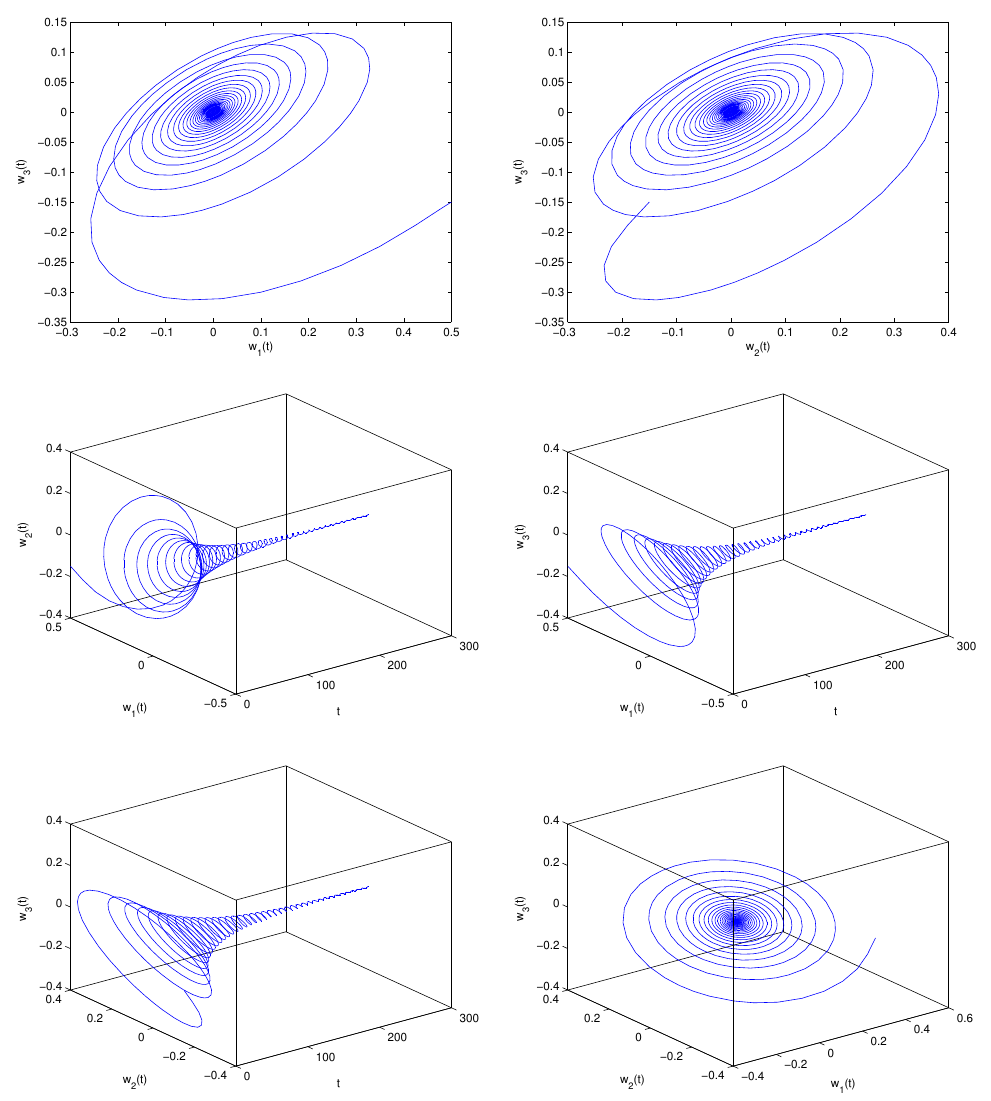
Figure 6. Computer simulation figures of system (96) with ρ = 0.24 < ρ (cid:63) ≈ 0.3. The three variables